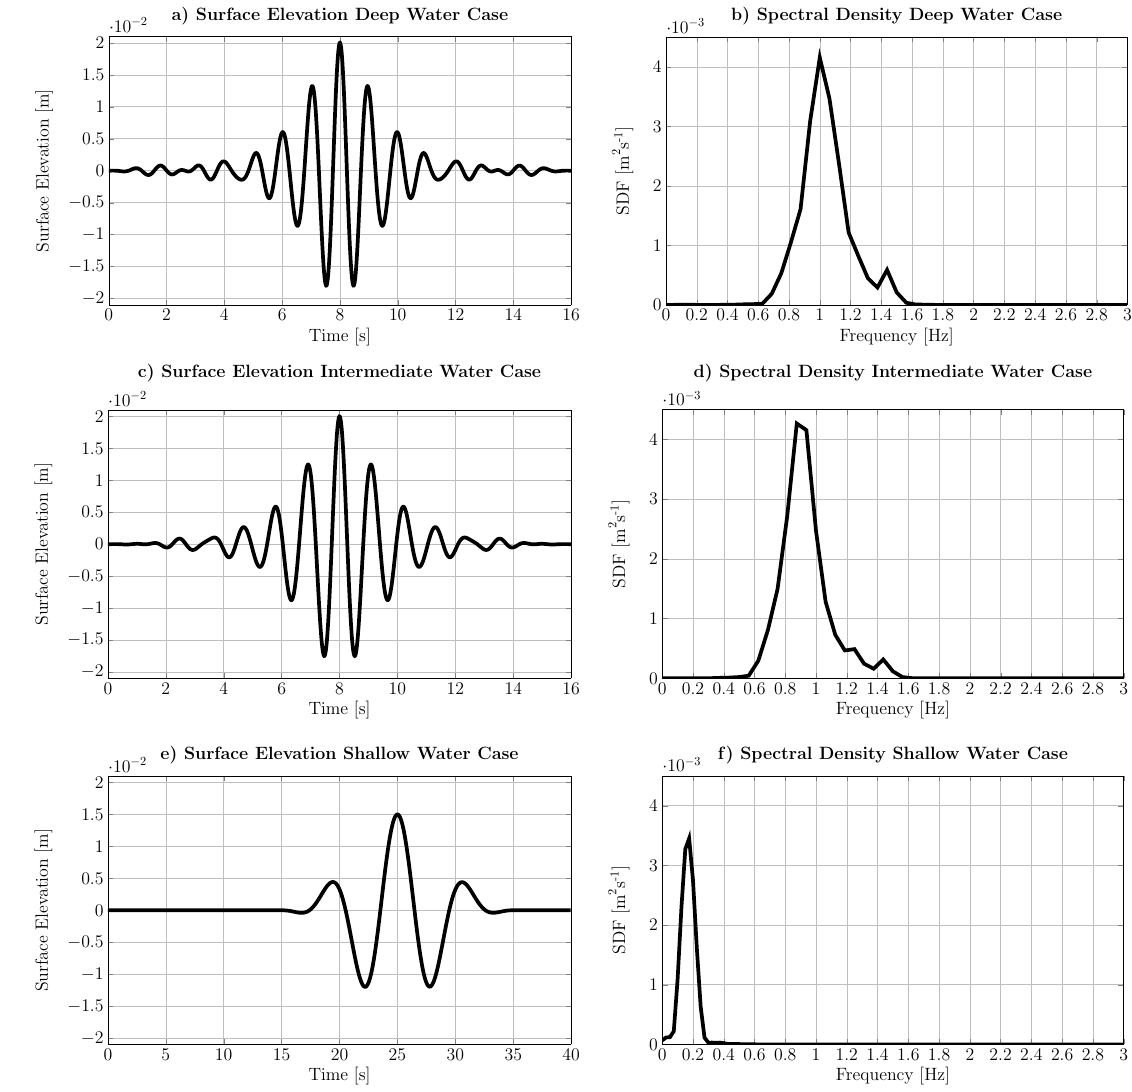
Figure 2. Target wave packet for the impulse wave maker to produce in the case study: surface elevation ( a , c , e ) and spectral density ( b , d , f ) for the deep (top), intermediate (middle) and shallow water case